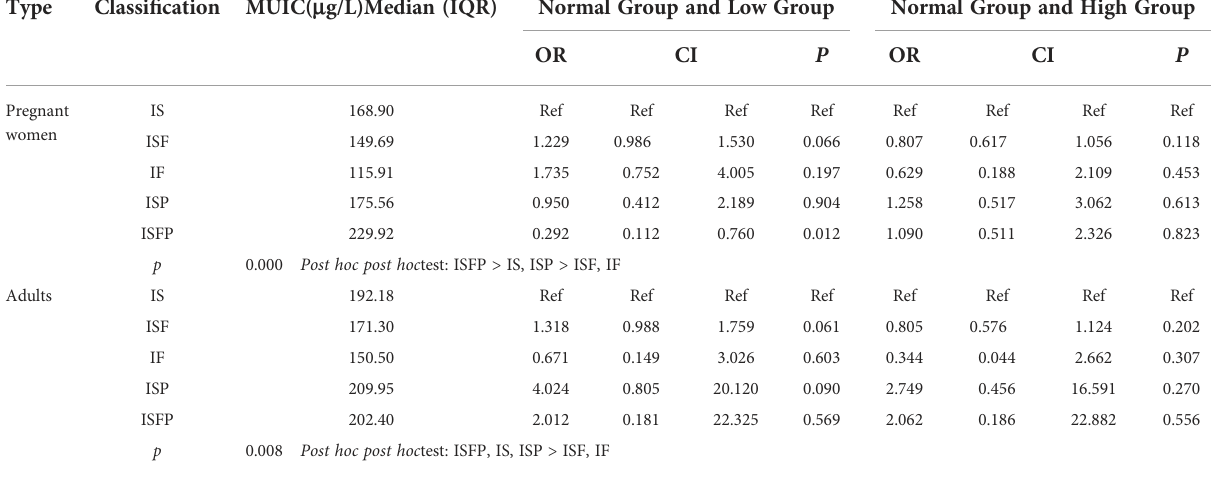
TABLE 4 The effect of iodine supplement measures on iodine